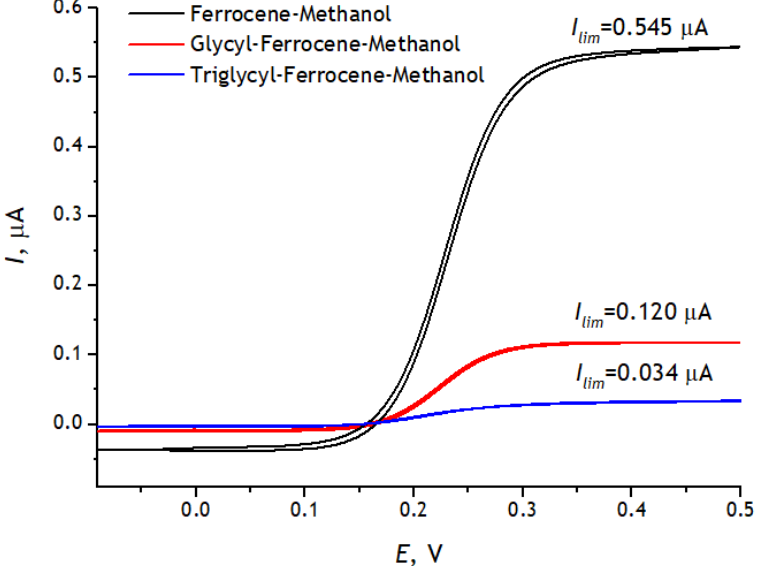
Figure 23. The dependence of the theoretical detection limit of a low molecular weight product in a mixture on the diffusion coefficient of a high molecular weight component.